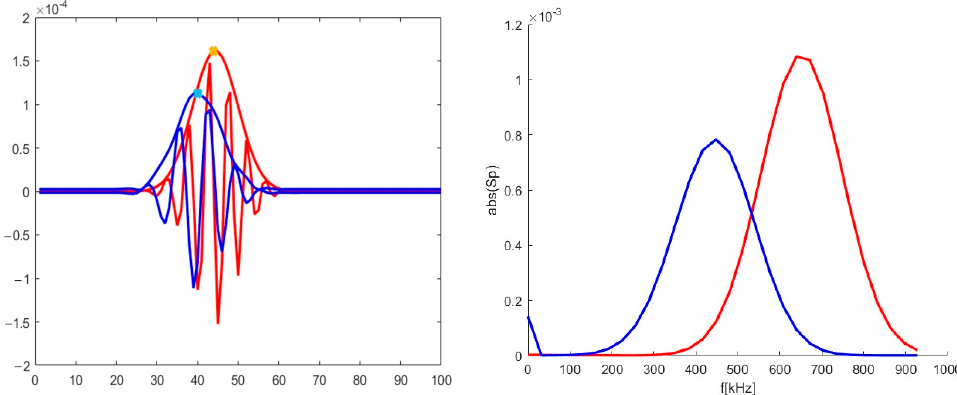
Figure 17. ( left ) DBS signals; ( right ) calculated spectra for the signal on the left. The blue lines correspond to the 39 GHz probing frequency, and the red lines correspond to 55 GHz.